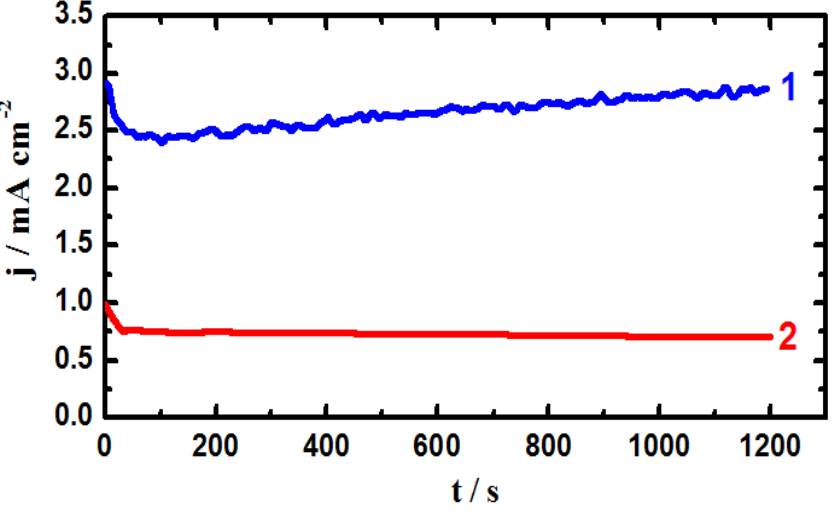
Figure 3. Chronoamperometric current-time curves obtained at − 0.350 V vs. Ag/AgCl for (1) iron and (2) API X-65 steel electrodes after 40 min immersions in 4.0 wt % NaCl